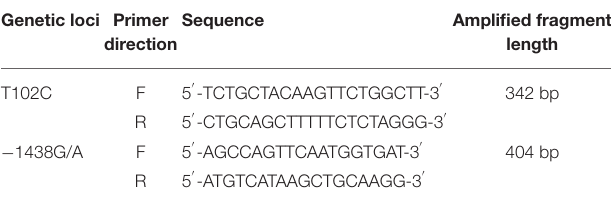
TABLE 1 | PCR primer sequences. Genetic loci Primer Sequence direction